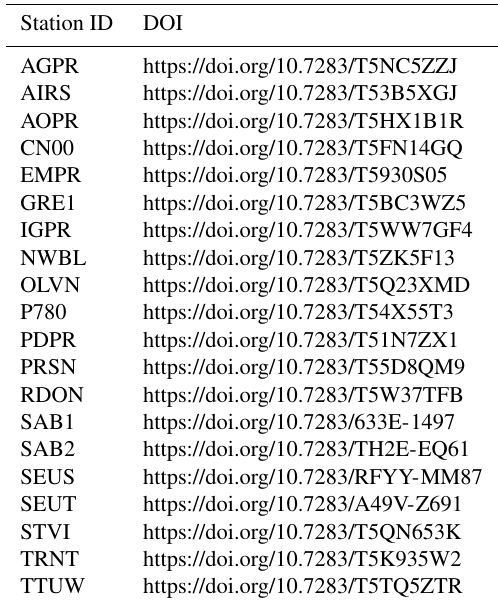
Figure A1. Comparison of refractivity coefficients from various au- thors. 1: Thayer (1974), 2: Bevis et al. (1994), 3: Rueger (2002), 4: this study. Table A1. List of DOIs associated with the UNAVCO GNSS sta- tions from which RINEX data have been used in this